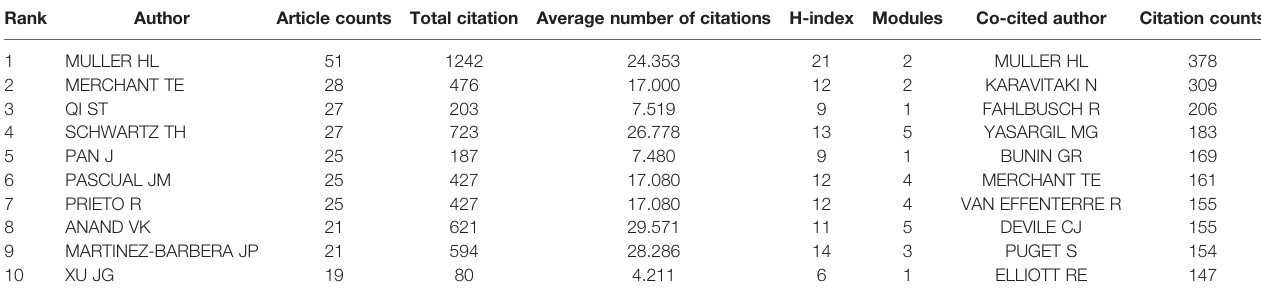
matrix visualization, the column tags represent source literatures and row tags represent keywords. The cluster trees on the left represent literature associations. The matrix values are